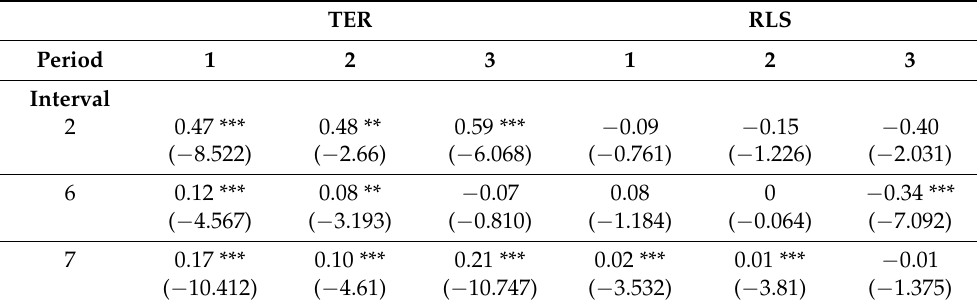
Table 5. By Study period: relationship between abnormal return and liquidity